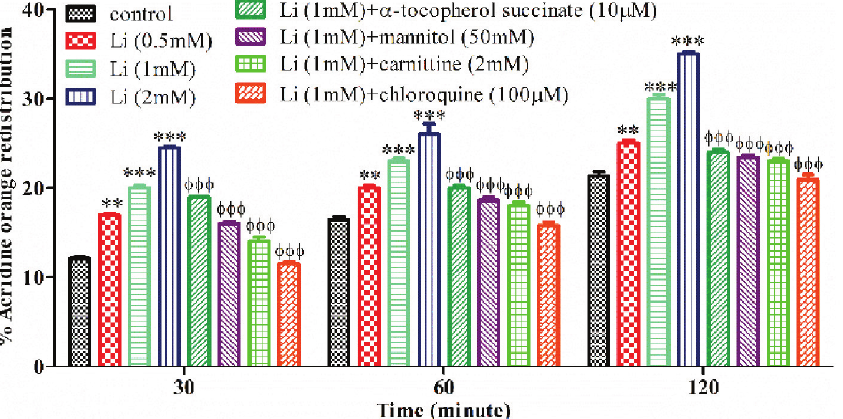
Figure 5: Effect of different concentrations of Li on lysosomal membrane degradation using primary neuronal cortical culture. The redistribution of acridine orange from lysosomes into cytosol in acridine orange loaded neurons was assigned as a biochemical basis for the measurement of lysosomal membrane injury. Highly florescent acridine orange redistribution was determined spectrofluorometrically in treated neurons and shown as the percentage of neurons lysosomal membrane leakage in all groups in three different time intervals.Values are shown as mean ± SD of three separate experiments (n = 3). ** p < 0. 01, *** p < 0.001, significant difference in comparison with non- treated neurons (control). ɸɸɸ p < 0.001, significant difference in comparison with Li (1 mM)-treated